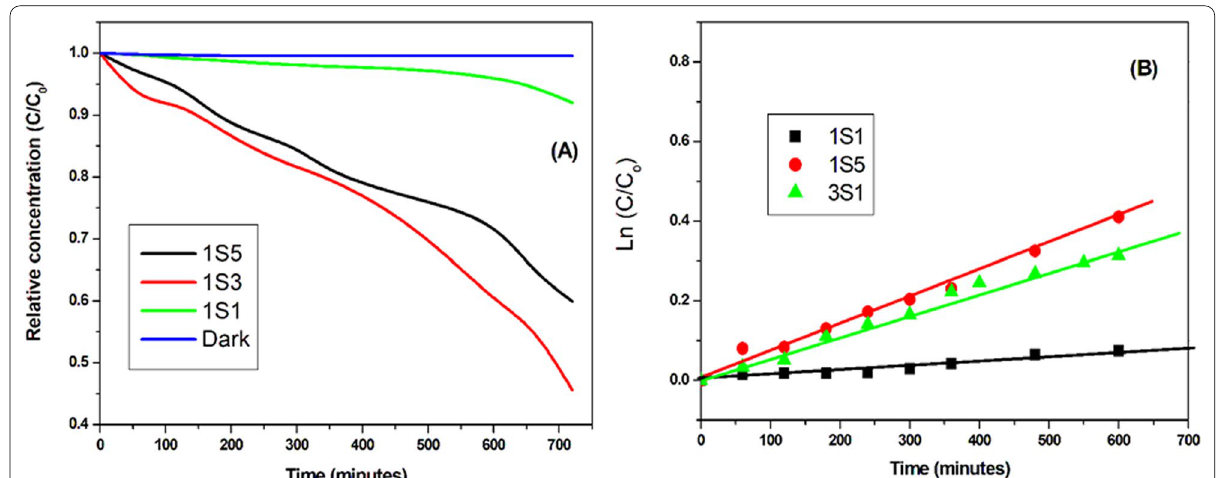
Fig. 6 A Plot of (C/C0) versus time for the samples 1S1, 1S5 and 3S1, B Plot of Ln (C 0 /C) versus decay time for degradation of 20 µM/L Rhodamine B aqueous solution in the presence of nano-fluid samples 1S1, 1S5 and 3S1